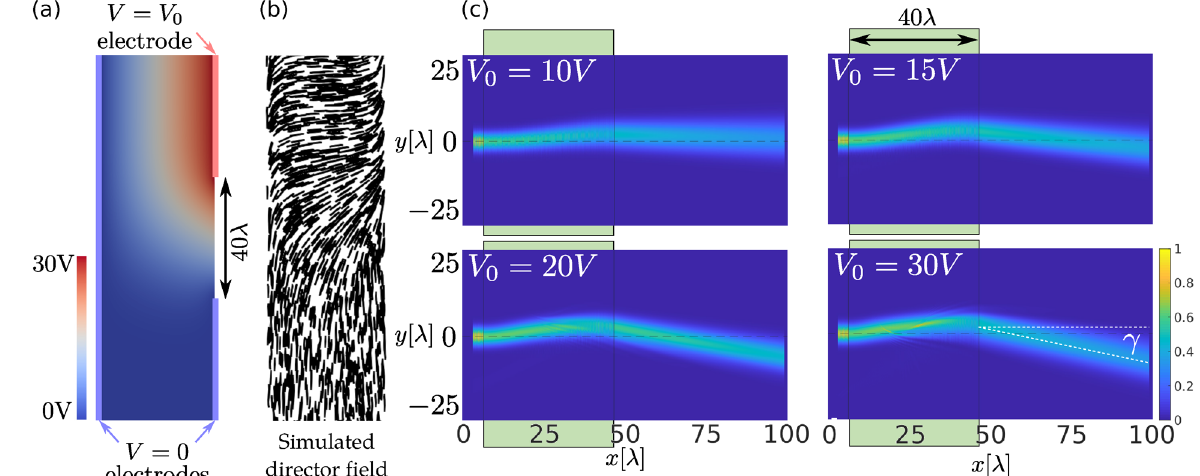
Figure 3. Deflecting the beam with a planar LC cell and applied voltage. ( a ) Electrode distribution and simulated electric potential for V 0 = 30V . ( b ) Simulated director field profile for electric potential shown in ( a ). Strong planar anchoring was used as a boundary condition on the electrodes. ( c ) Simulated light deflection by use of simulated director field for four different voltages at the electrode. Waist of the beam was set to w 0 = 3.33 (cid:31) , while the length of the building block was fixed to d 2 = 40 (cid:31)